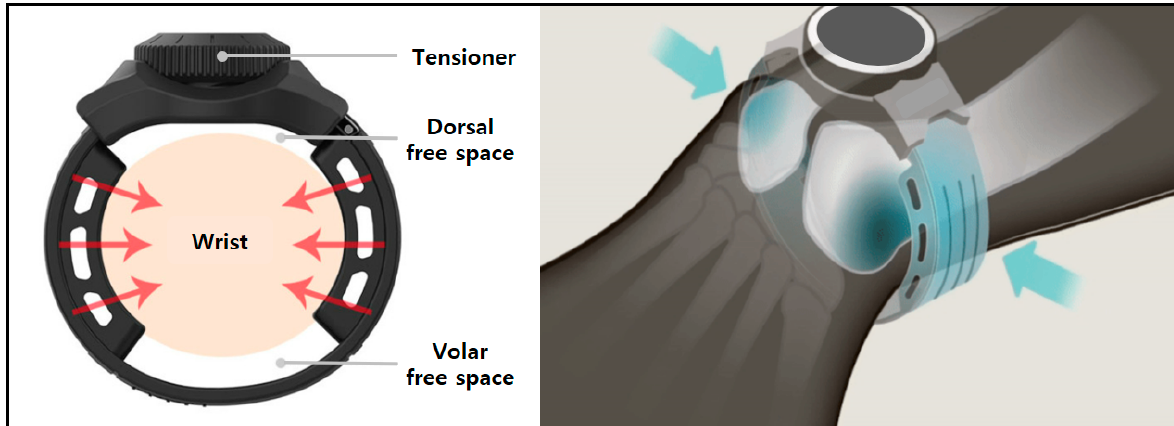
Figure 1. Structure and concept of the external wrist band brace.